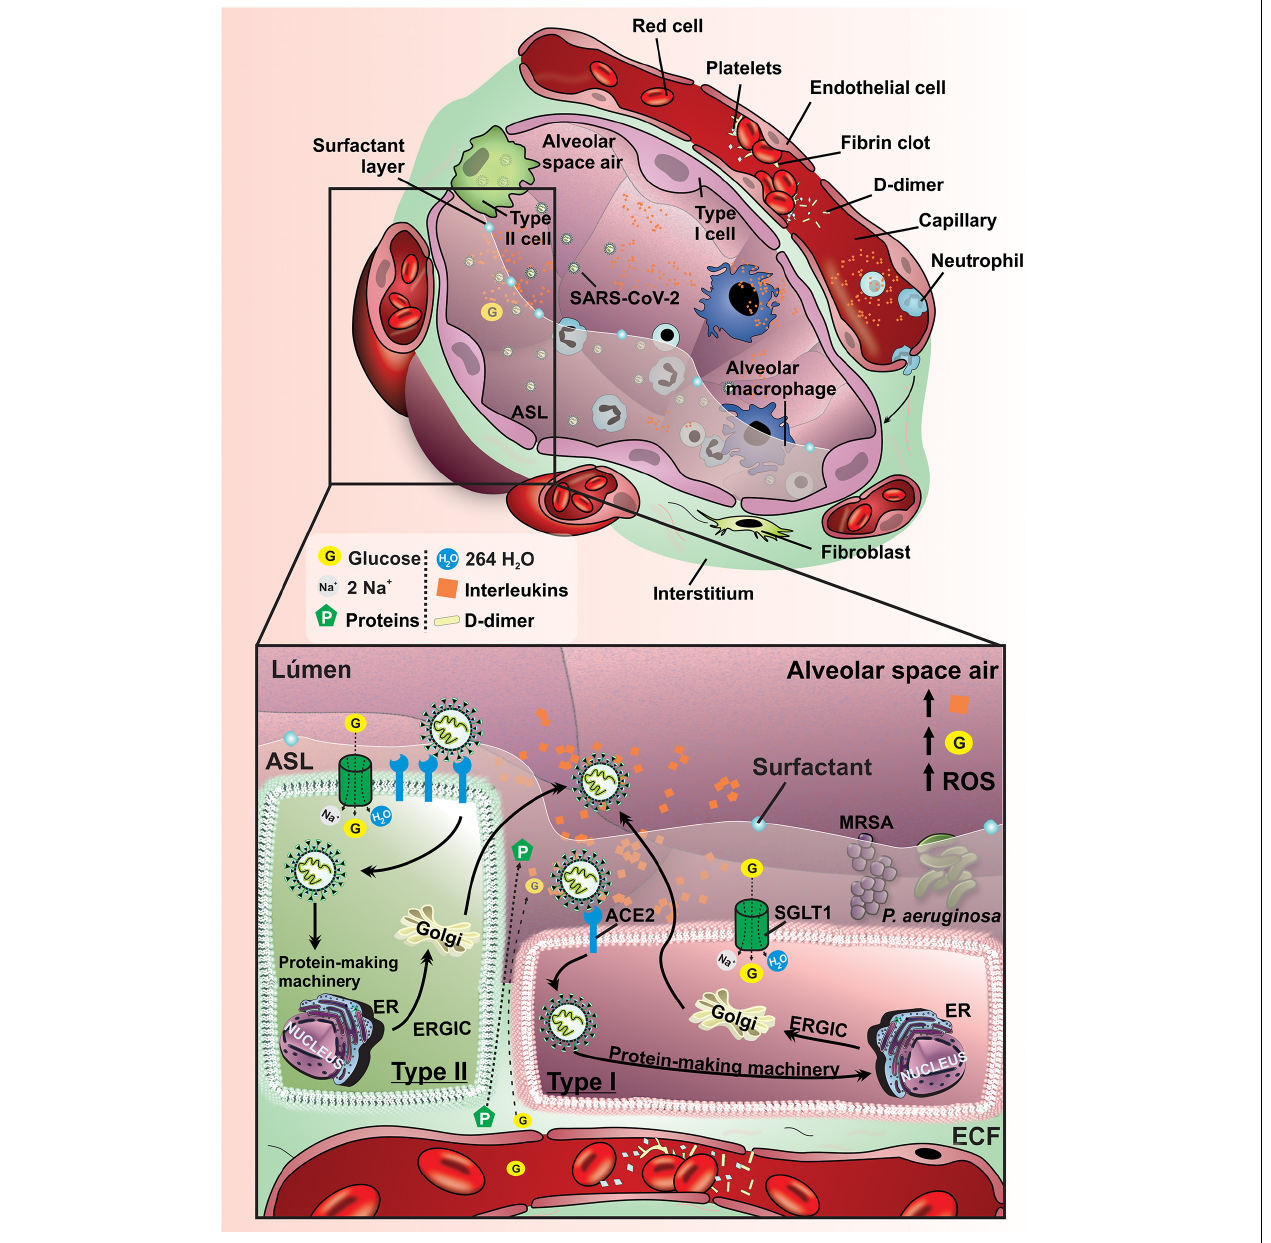
FIGURE 4 | Pathophysiological mechanisms affecting lung function and ASL glucose concentration COVID-19 patients. Schematic representation of pathophysiological mechanisms related to SARS-CoV-2 infection in the lung of non-diabetic subjects. Spike glycoproteins from the SARS-CoV-2 envelope binds to ACE2, allowing the inoculation of the viral genome into type I and II pneumocytes. The virus uses the host cells machinery to replicate and infect other cells, which can result in the activation of an inflammatory cascade as well as promoting damage to the vascular endothelium. These changes promote an increase of the production of interleukins, activation of ROS, damage to the alveolar epithelium and endothelium, which allows the leakage of liquid and glucose from the interstitium into the alveoli. These changes provide an increased risk for pneumonia due to the proliferation of bacteria P. aeruginosa and MRSA. G, glucose; SGLT1, Na + /glucose/H 2 O type 1 cotransporter; ECF, extracellular fluid; ER, endoplasmic reticulum; ERGIC, endoplasmic reticulum-Golgi intermediate compartment; ACE2r, receptor angiotensin-converting enzyme 2; ROS, reactive oxygen species; P. aeruginosa , Pseudomonas aeruginosa ; MRSA, Methicillin-resistant Staphylococcus aureus ; Orange rhombus: